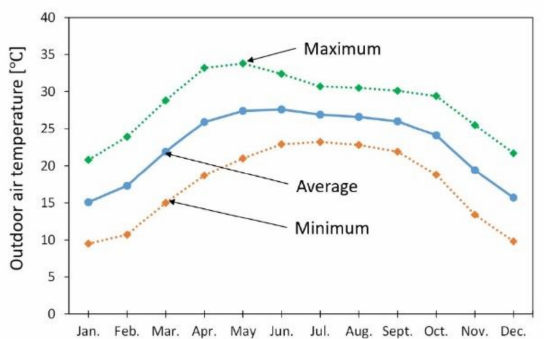
Figure 2. Monthly outdoor air temperatures of the study area, obtained from the climatological and agro-meteorological records of